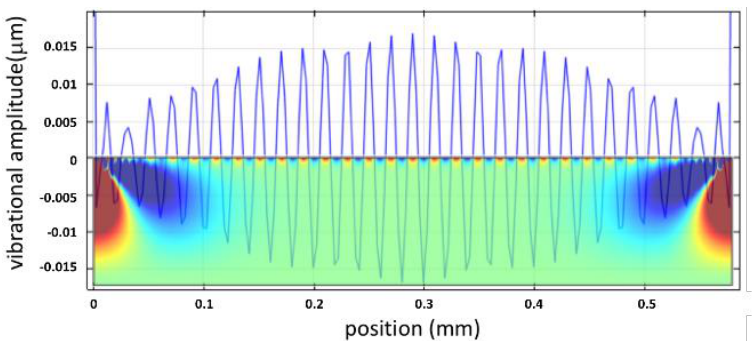
Figure 9. The vibrational amplitude is waved across the water surface for h e = 0.38 μ m. The inserted figure is the 2D velocity profile in the water tank for 6 × 10 −4 sec simulation time.